Question: Which kind of chart has been used to present this data?
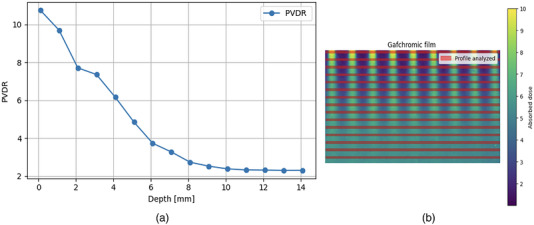
Answer: line